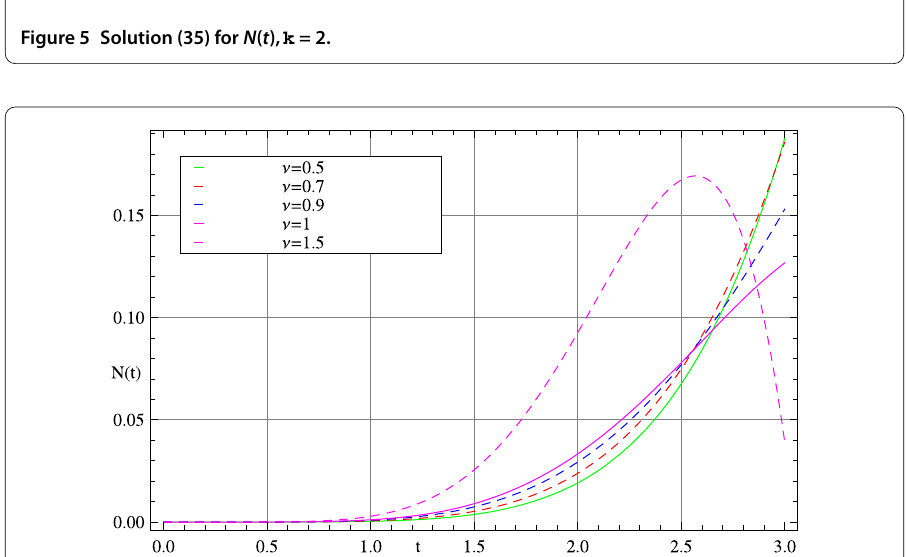
Figure 6 Solution (35) for N ( t ), k =